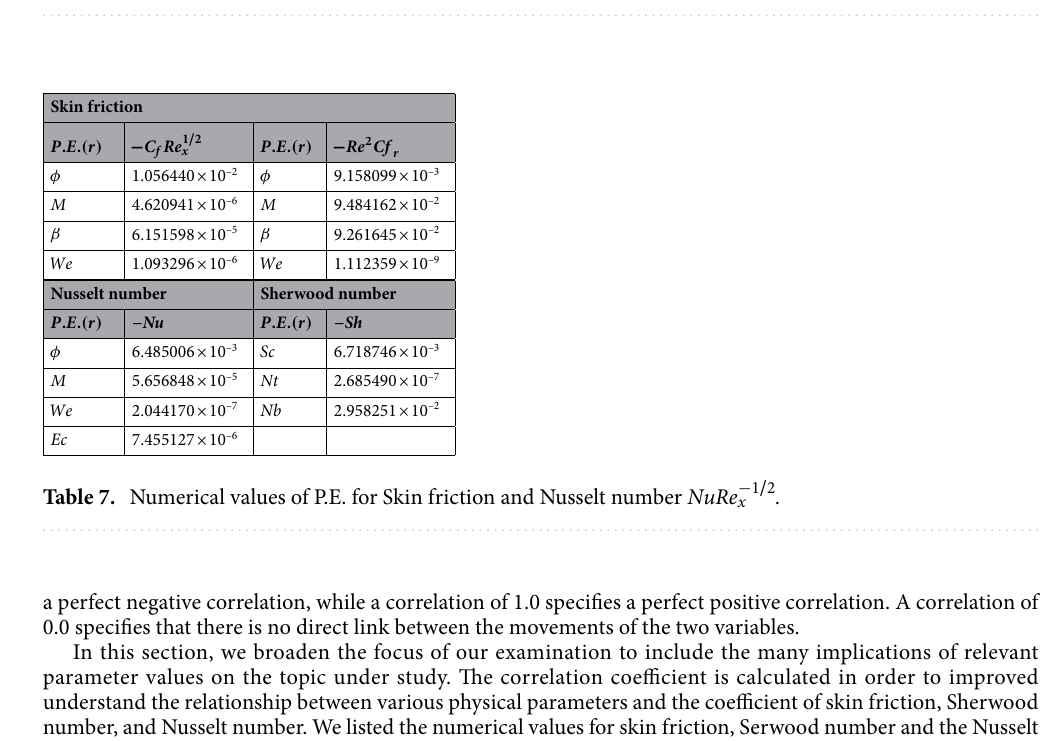
Table 6. Numerical values of correlation coefficient for Skin friction and Nusselt number and Sherwood number.